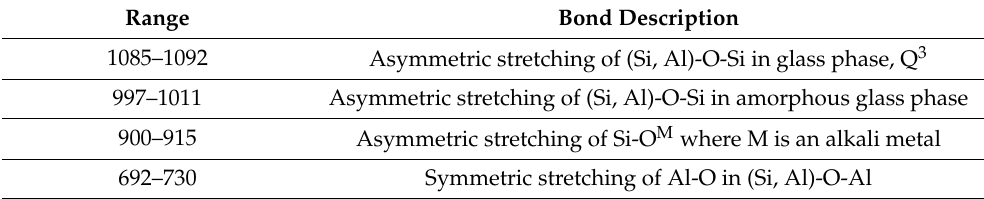
Table 2. FTIR range of active bonds in geopolymerization (adopted from Ref